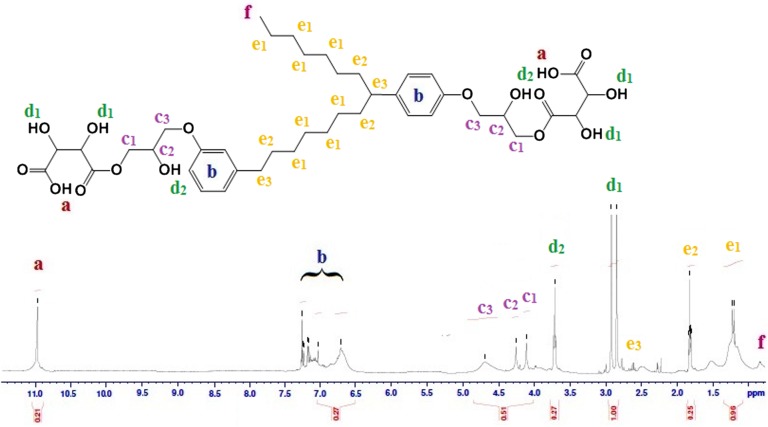

1H-NMR of cardanol based polyol.